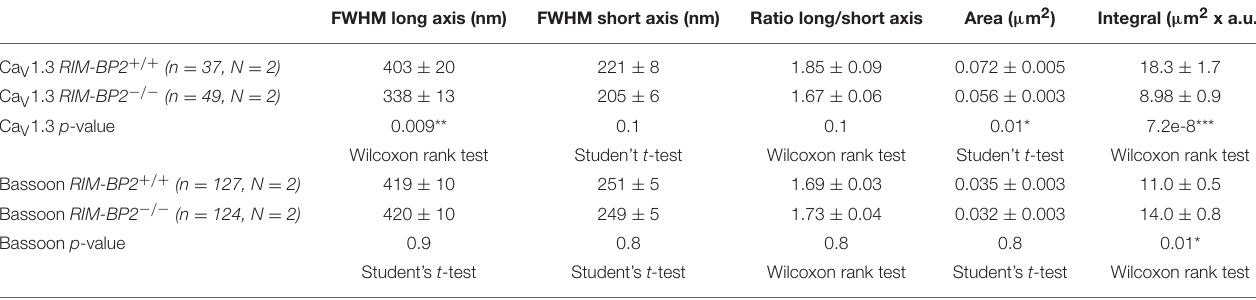
TABLE 2 | Summary of Ca V 1.3 and bassoon STED image quantification data. FWHM long axis